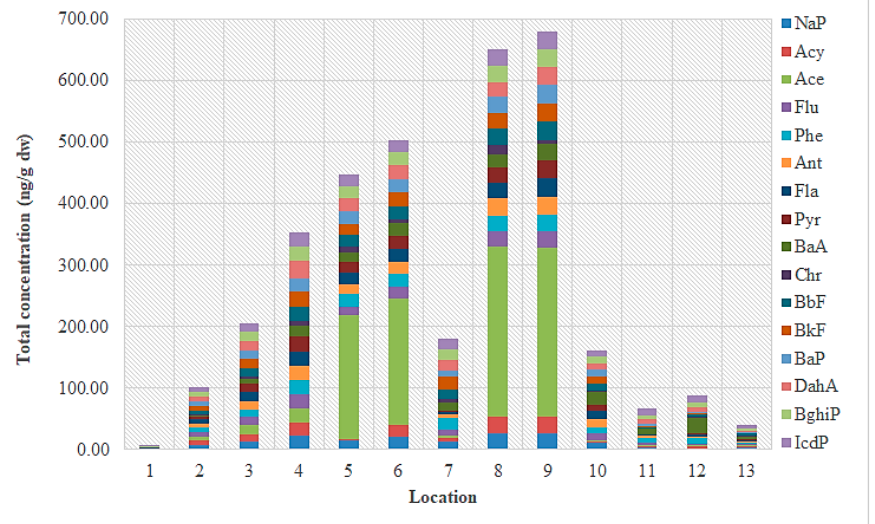
Figure 7. Concentrations of the 16 priority PAHs (ng/g dw) found in sediment samples from the Sarno River at the 13 sampling sites (April 2008).